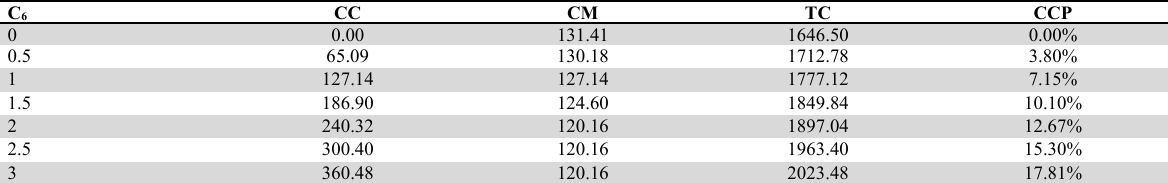
Experimental results on different carbon